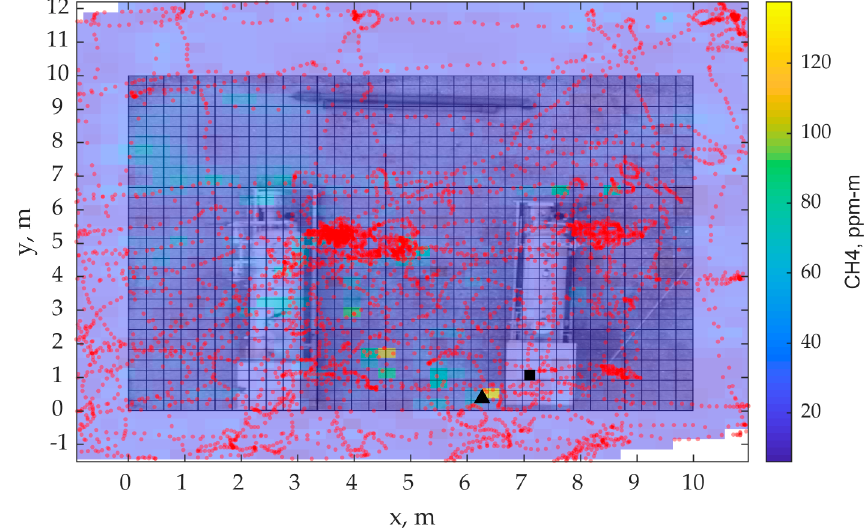
Figure 4. Maxima-based location method: The highest methane concentration is seen slightly southwest of the rightmost separator, which is flagged as the probable leak location, where right corresponds with east and up with north. Here, the location of the maximum methane on this interpolated grid is shown with a triangle. This is shown in comparison to the real leak location designated with a square. Red lines indicate the RMLD-UAV flight tracks. The dominant wind direction was measured to be southeasterly.